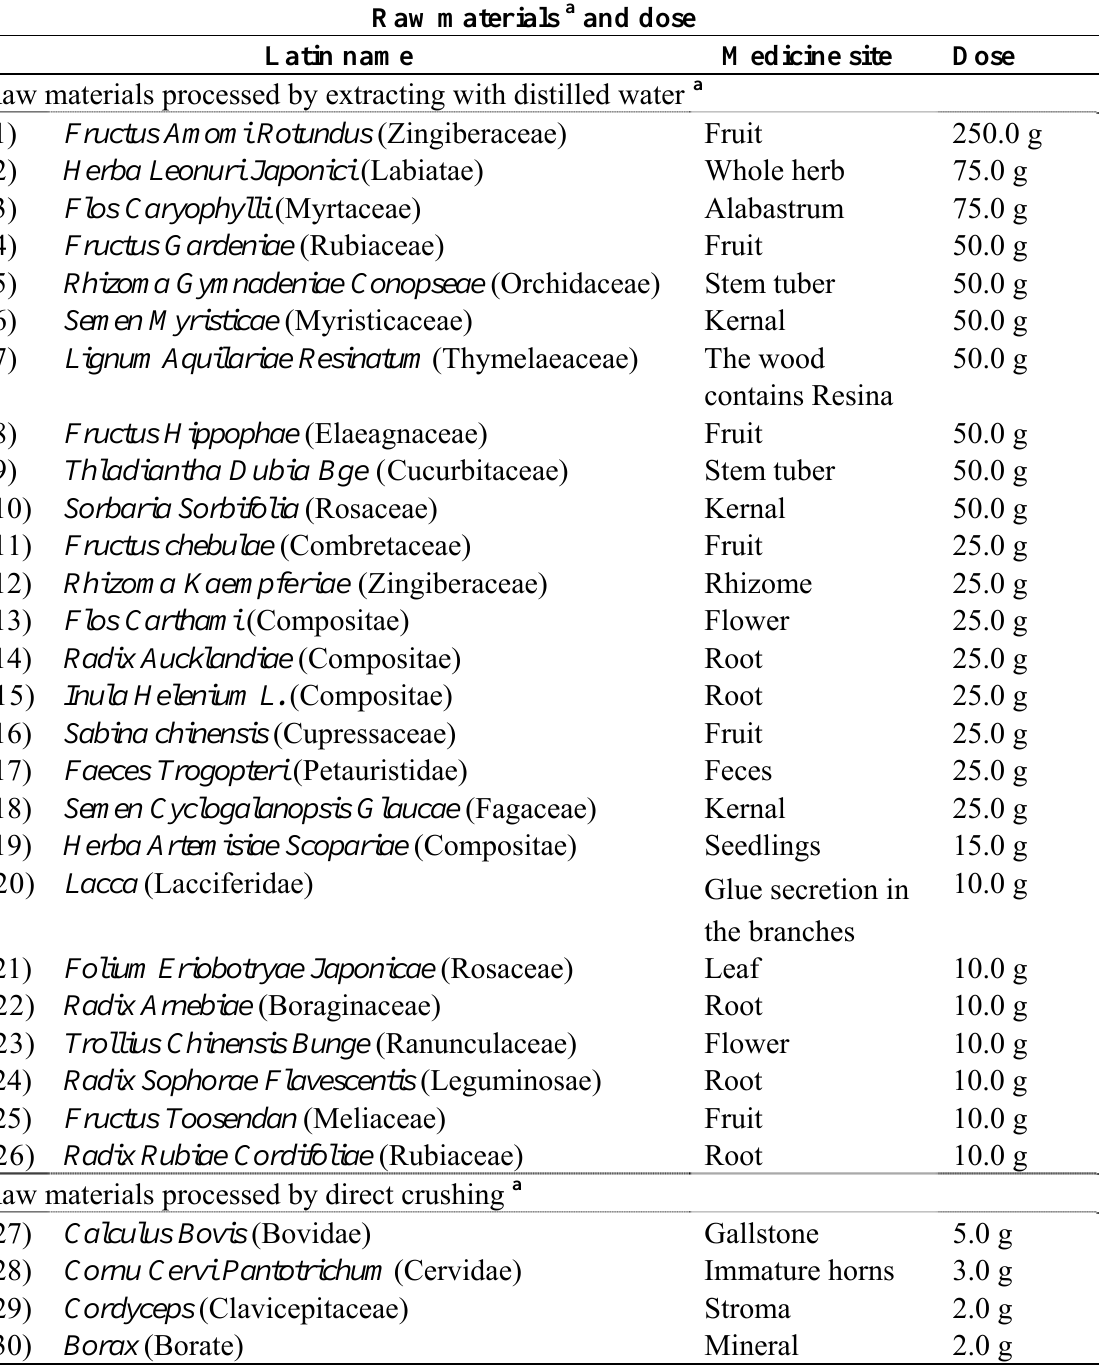
Table 3. The components of